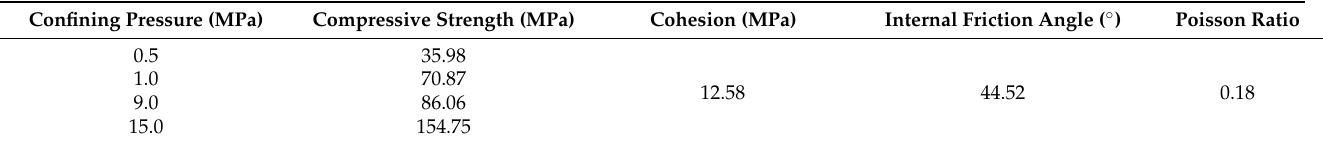
Table 2. Results of conventional triaxial compression